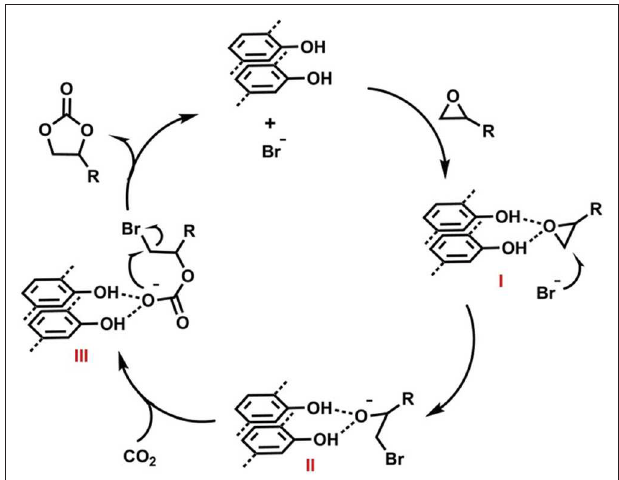
FIGURE 23 | Mechanism proposed by Zhi et al. (2018) for the formation of cyclic carbonates from CO 2 and epoxides as catalyzed by COF-JLU6 or COF-JLU7. Reprinted with permission © 2017 The Royal Society of